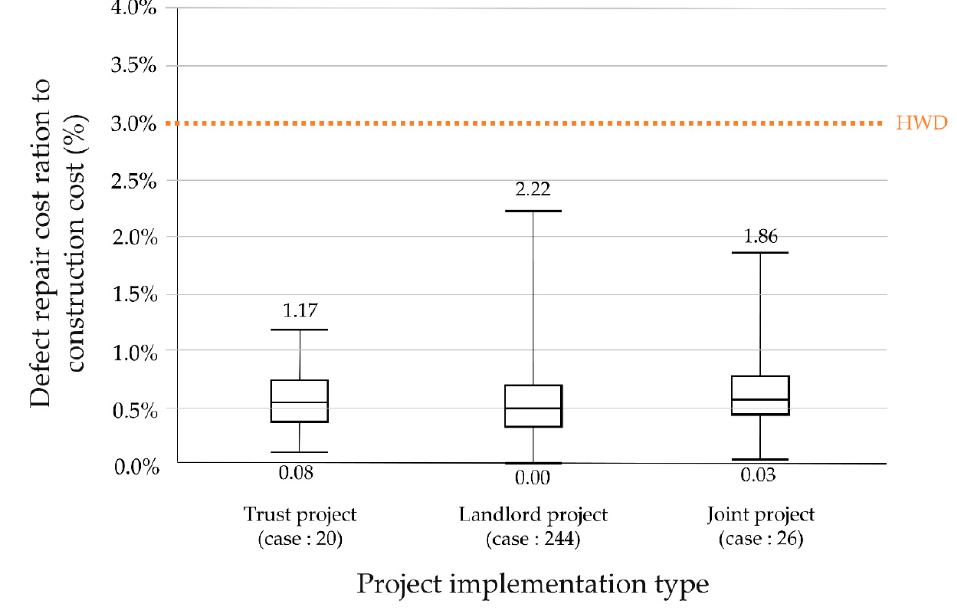
Figure 7. Comparison of project implementation type.